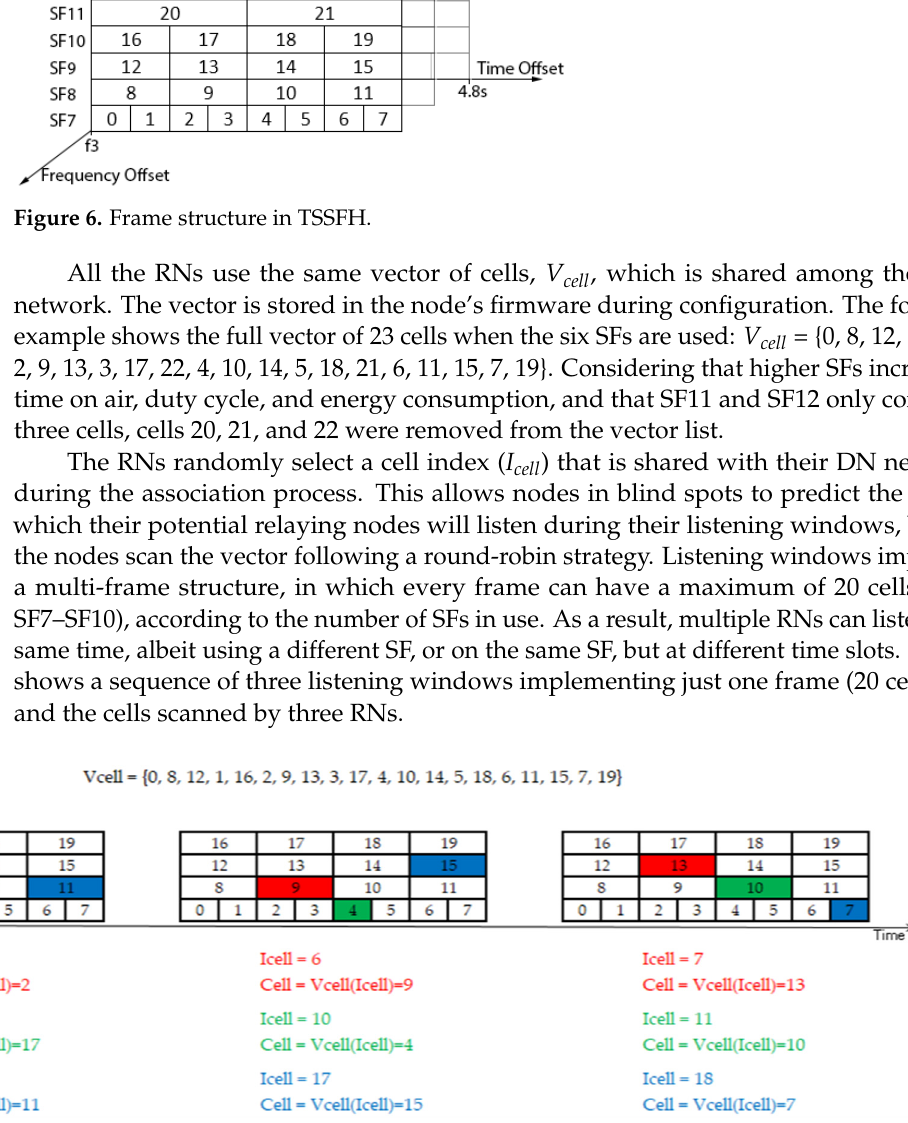
Figure 7. Cells scanned by three relay nodes during three consecutive listening windows.